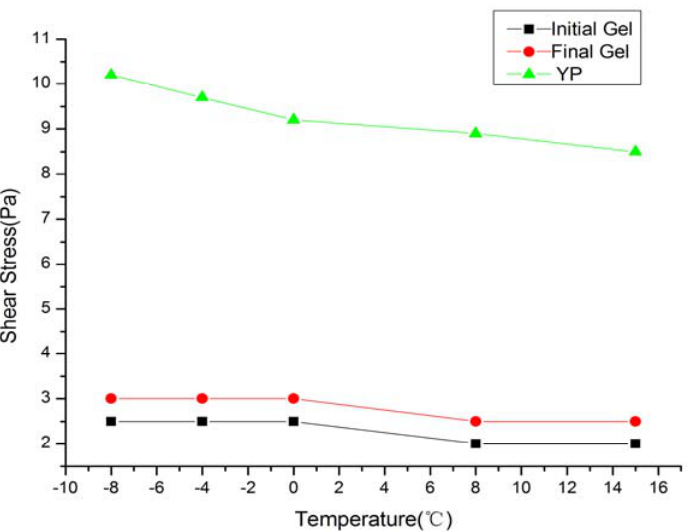
Figure 3. The change of gel strength and yield point of polyethylene glycol drilling fluid at different